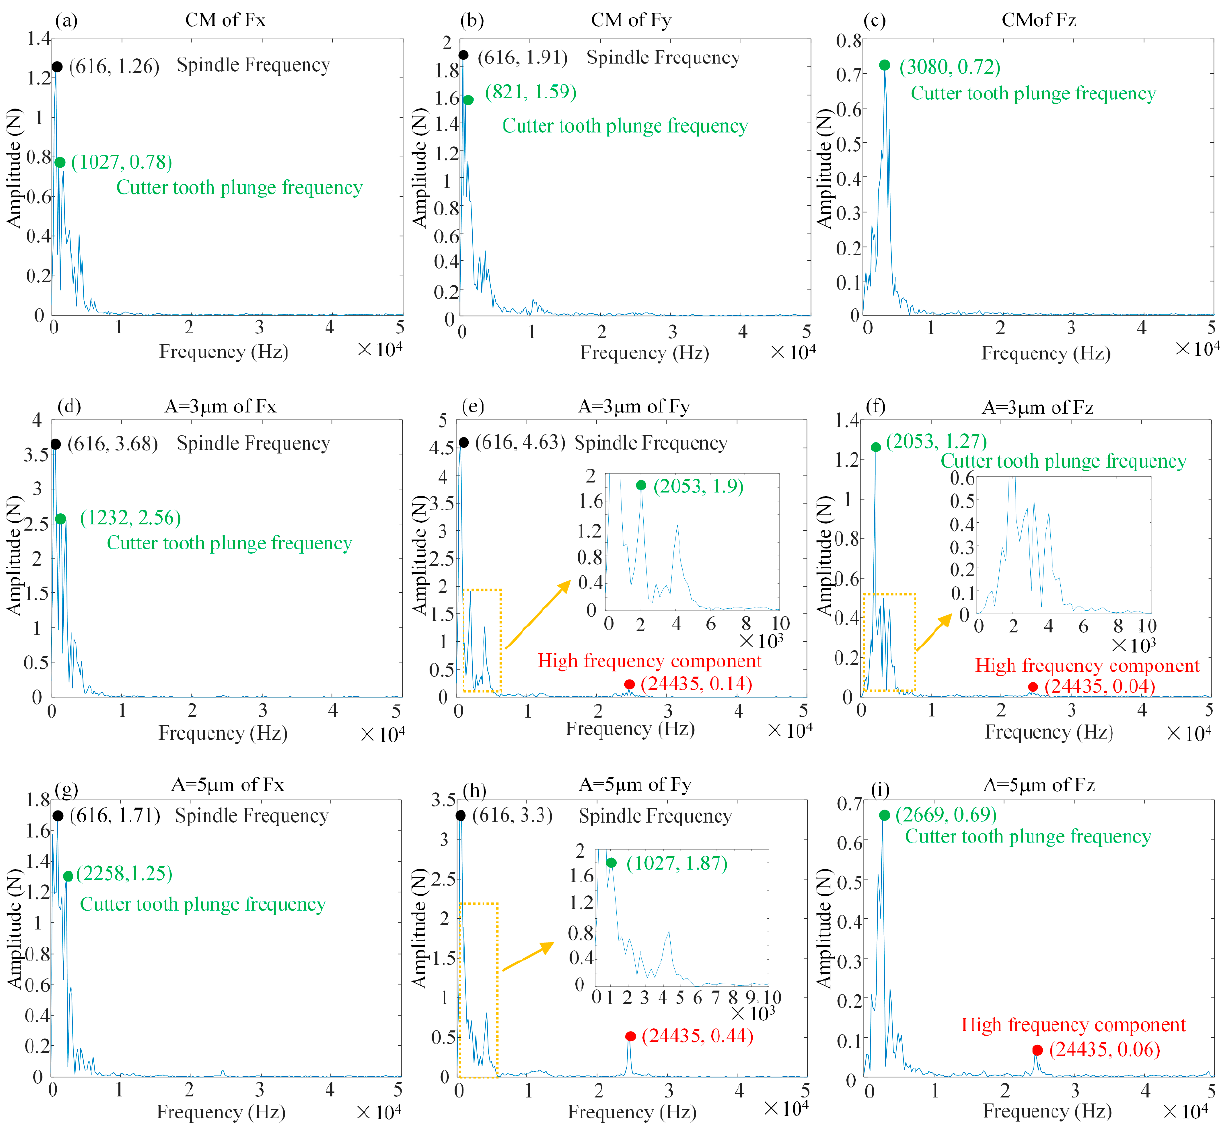
Figure 9. Milling force spectrum characteristics ( n s = 8000 r/min, f z = 10 µ m, a p = 0.5 mm). ( a – c ) Spectrum analysis of milling forces Fx , Fy and Fz for conventional machining; ( d – f ) Spectrum analysis of milling forces Fx , Fy and Fz for ultrasonic vibration amplitude A = 3 µ m; ( g – i ) Spectrum analysis of milling forces Fx , Fy and Fz for ultrasonic vibration amplitude A = 5 µ